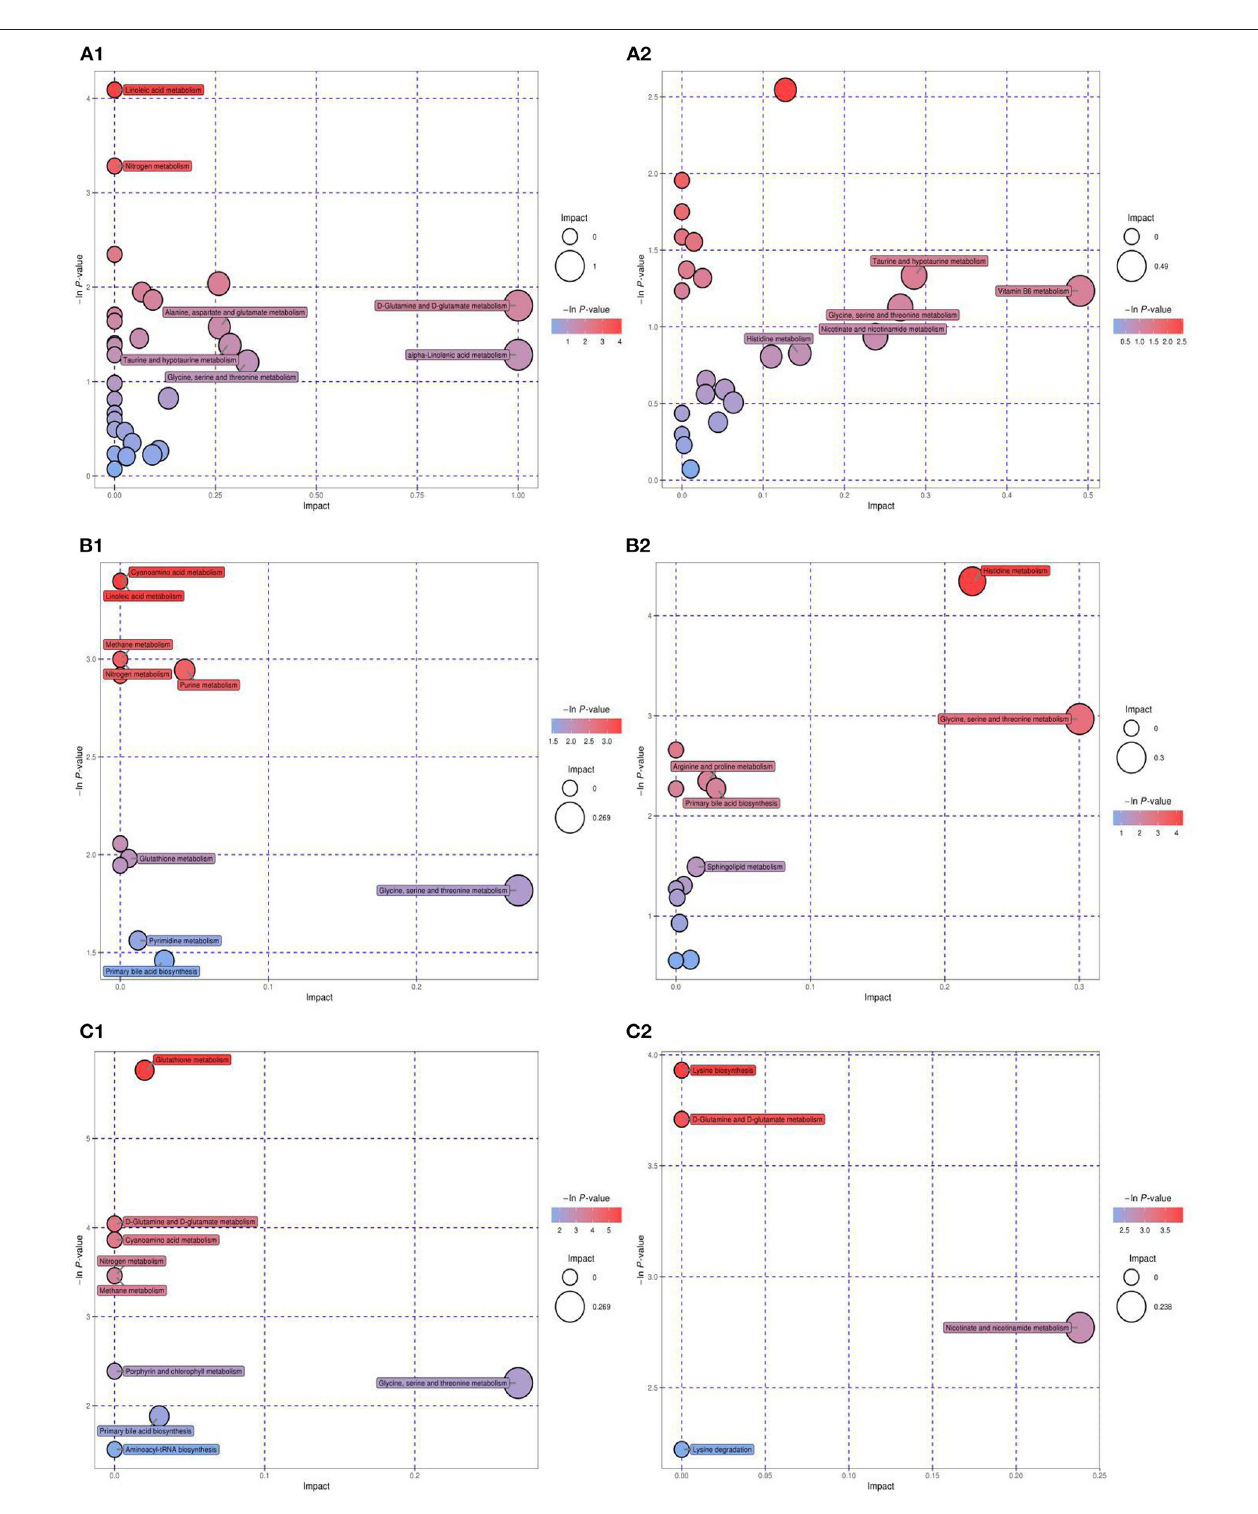
FIGURE 10 | KEGG pathway analysis and differential abundance analysis diagram. NCD vs. HFD [ (A 1 ) NEG ion, (A 2 ) POS ion], NCD vs. NCD + MBPs [ (B 1 ) NEG ion, (B 2 ) POS ion], HFD vs. HFD + MBPs [ (C 1 ) NEG ion, (C 2 ) POS ion]. Different colors of pathways indicate that pathways belong to different metabolic classifications. Line segments indicate the up-regulated or down-regulated of this pathway. Positive value of line segments indicates the overall up-regulation of this pathway; otherwise, it indicates the overall down-regulation of this pathway. The size of the end point of the line segment indicates the amount of substance annotated in the pathway.